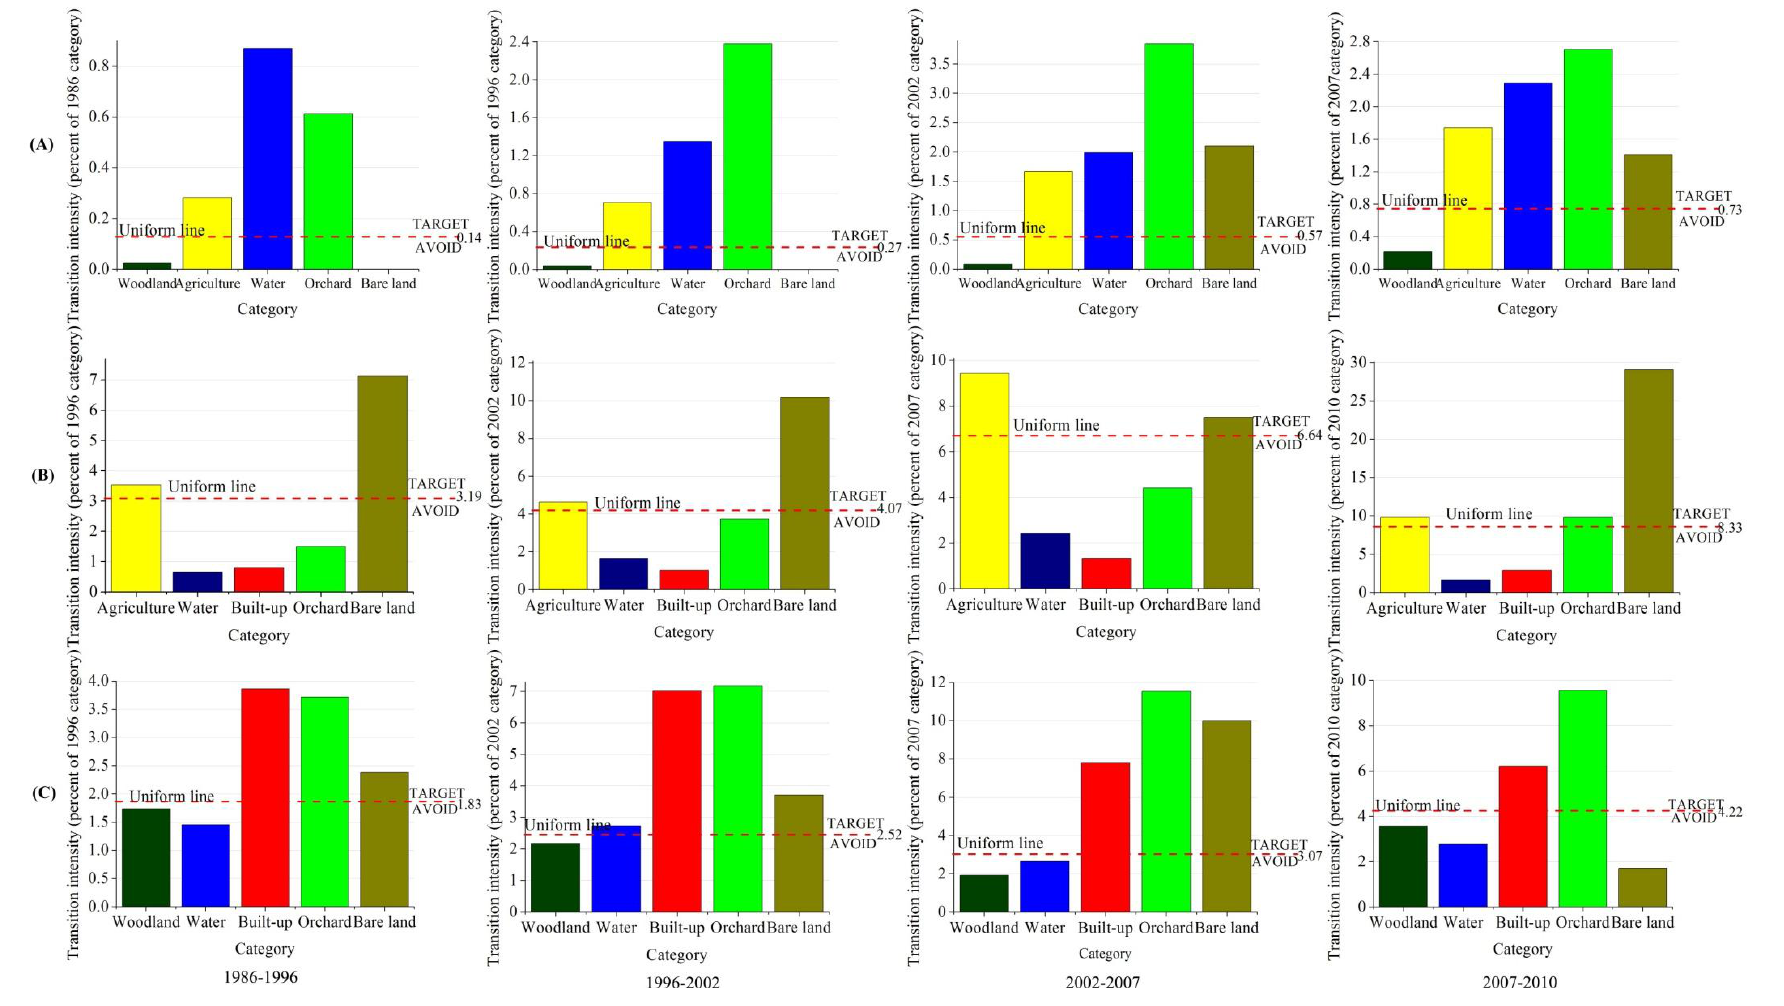
Figure 9. Transition intensities from Woodland, Agriculture, Orchard and Water to Built-up, where figures in row A represent gains to Woodland, Agriculture, Orchard and Water during the same intervals